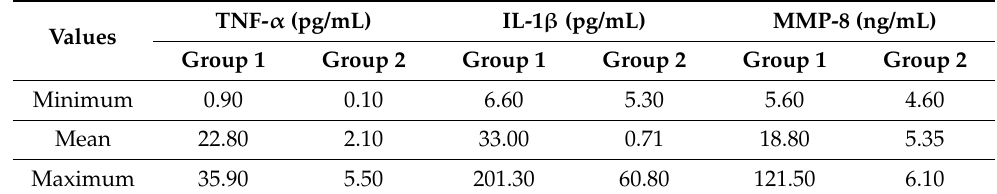
Table 4. GCF immune biochemical biomarkers levels in study group versus control